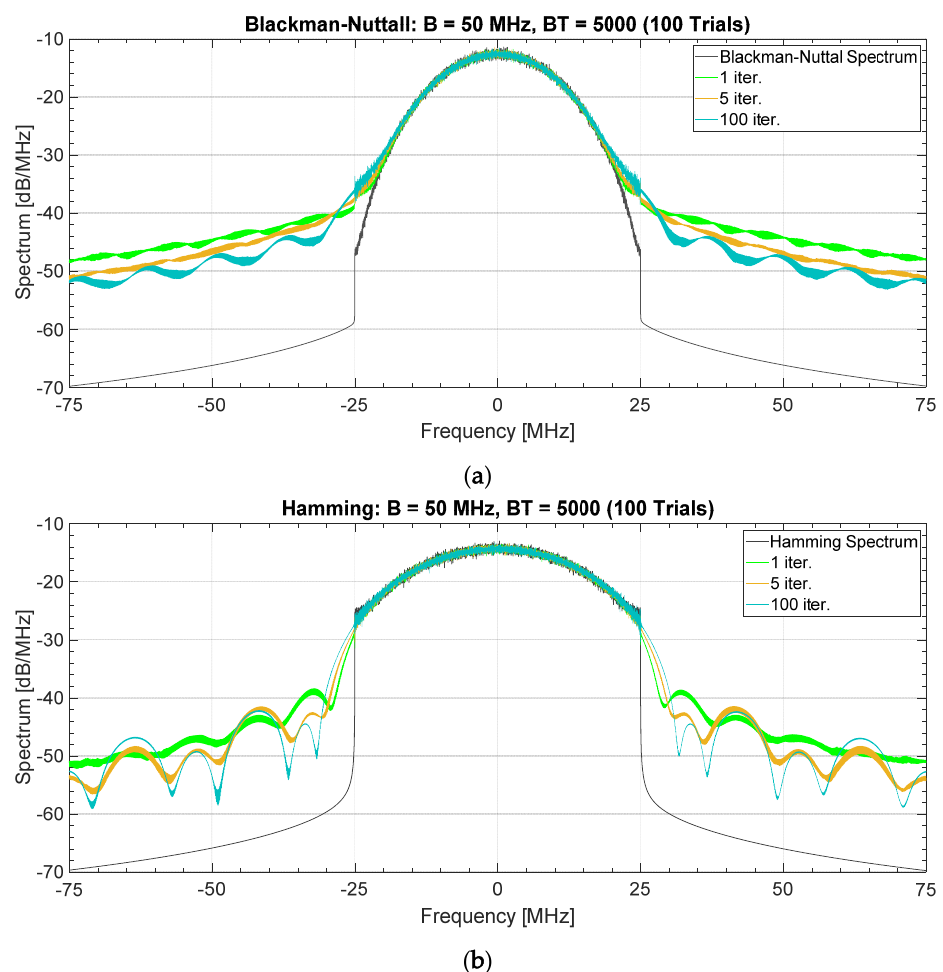
Figure 19. Mean spectrum (FMeth, 100 trials) varying the number of iterations: n iter = 1, 5, and 100. The PAPR assumes its “natural” value in the range 10–12. The suppression zone is the 20% of the total. ( a ) Blackman-Nuttall spectrum, and ( b ) Hamming spectrum.